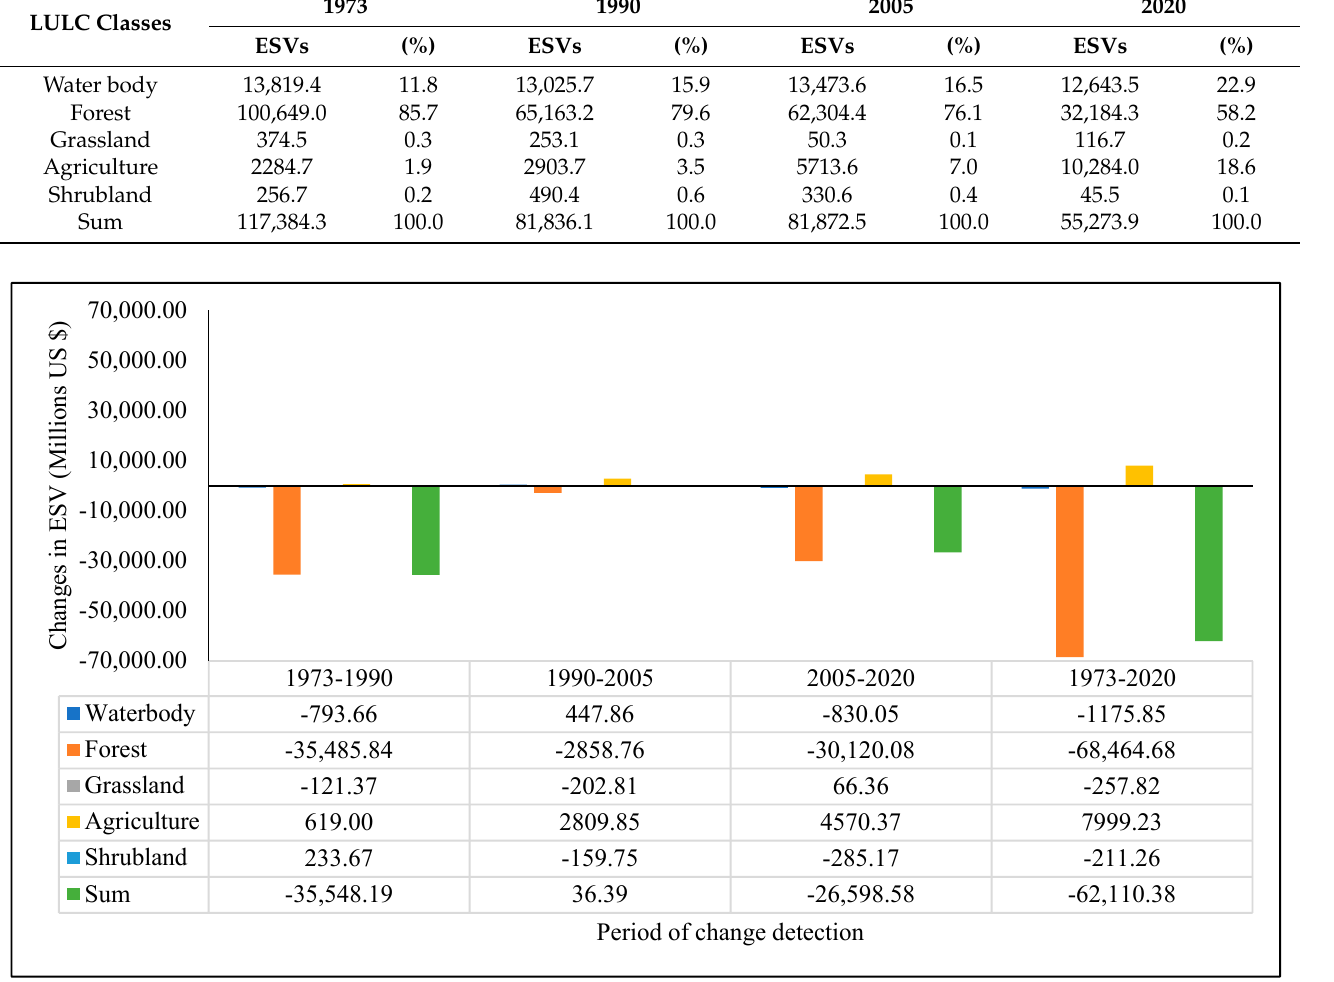
Figure 4. Changes in ecosystem service values (ESVs) (in millions of US $; 2020 price levels) in the Central Rift Valley lakes basin, Ethiopia.